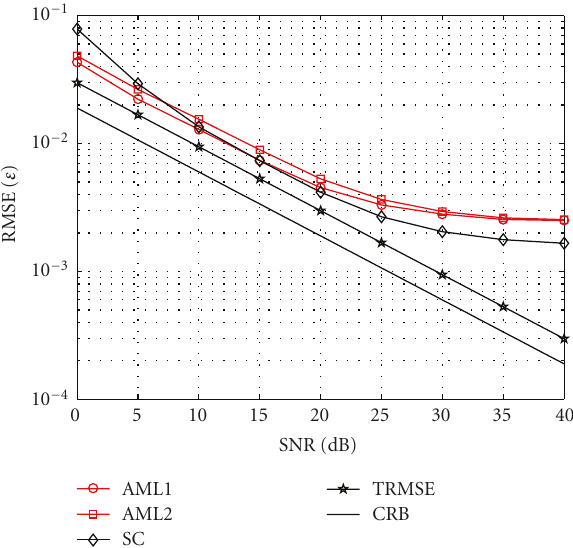
Figure 3: Performance of the considered CFO estimators in AWGN channel.